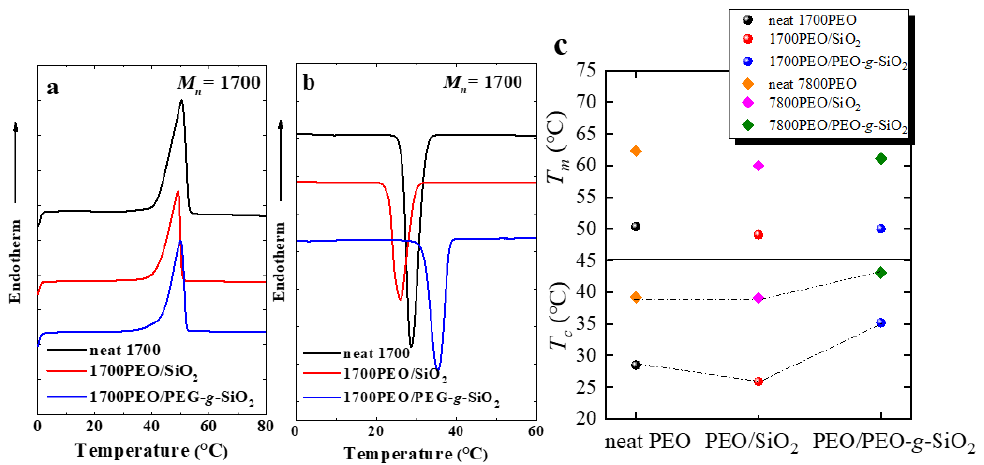
Figure 1. DSC heating ( a , b ) cooling scans of neat PEO, PEO/SiO 2, and PEO/PEG- g -SiO 2 with a matrix molecular weight of 1700 g/mol. ( c ) The changes in the T c and T m for the two different nanocomposites with matrix molecular weights of 1700 g/mol and 7800 g/mol, and the silica content is 24 wt% in the nanocomposites studied here.